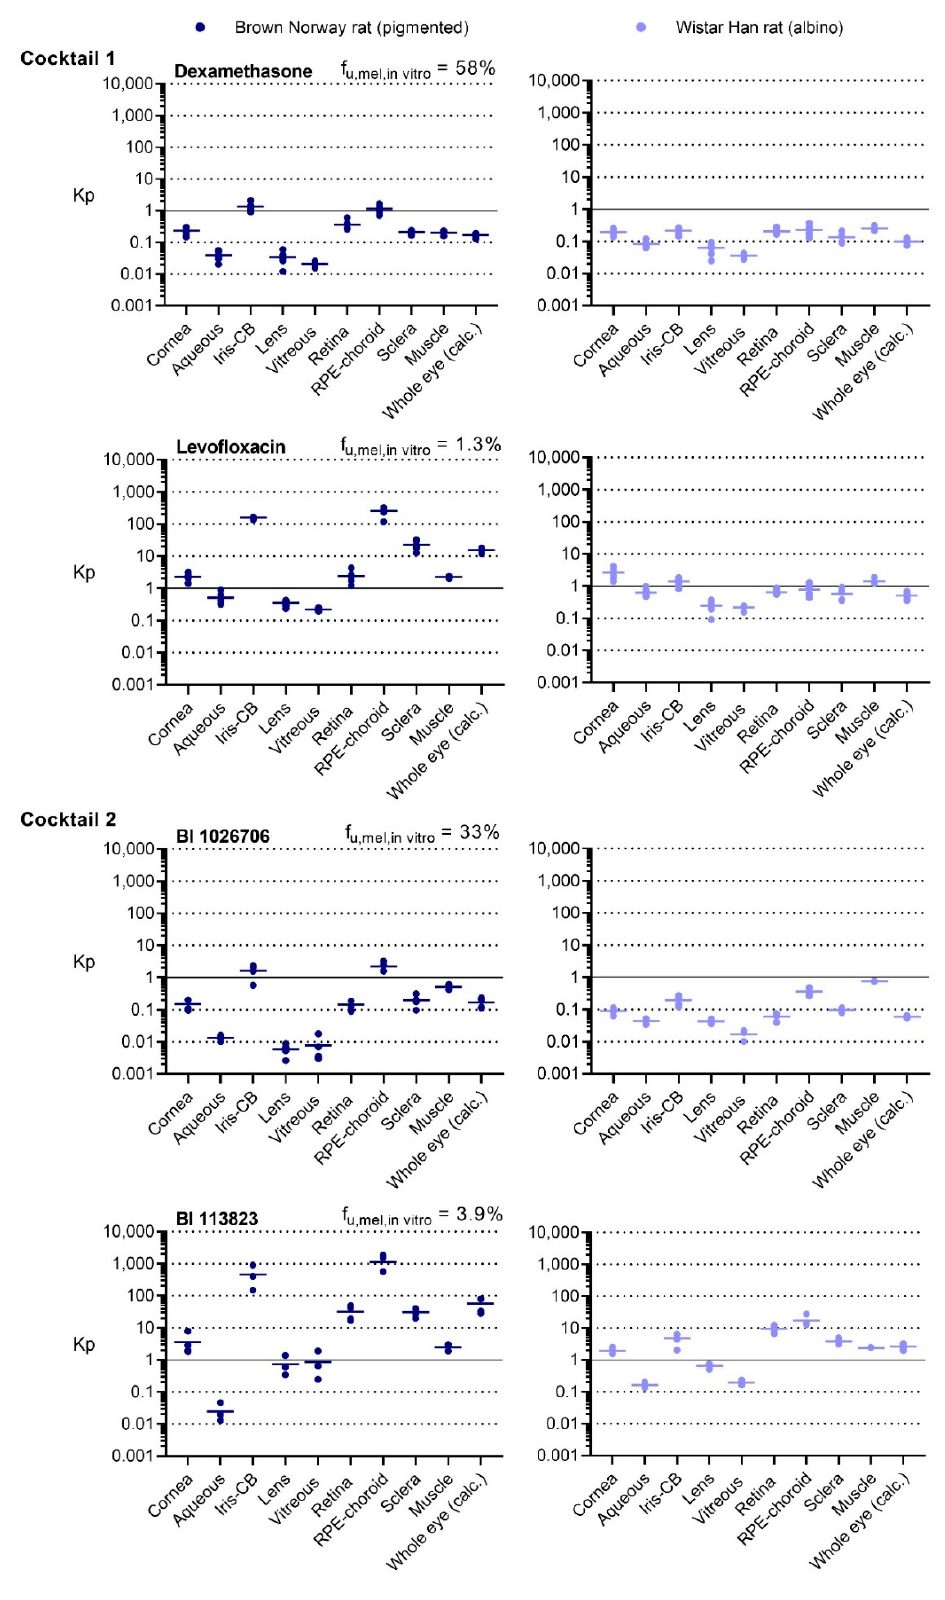
Figure 3. Tissue partitioning (Kp) of the compounds 8 h after oral administration to rats. The individual values for each eye (n = 4–6 eyes) are shown and the mean is presented as a line. Whole eye value was calculated (calc.) with hypothetical volumes (Table S3) for the individual tissues. The measured in vitro melanin binding (1 mg / mL melanin, 1 µ M compound) is shown for each compound (f u,mel,in vitro